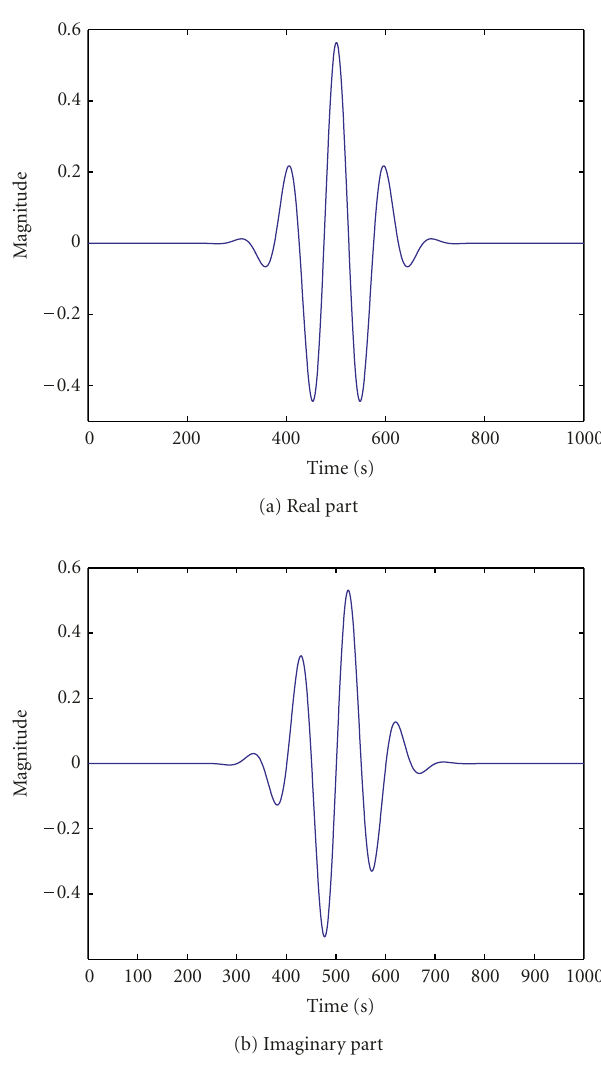
Figure 1: The real part and imaginary part of the complex Morlet